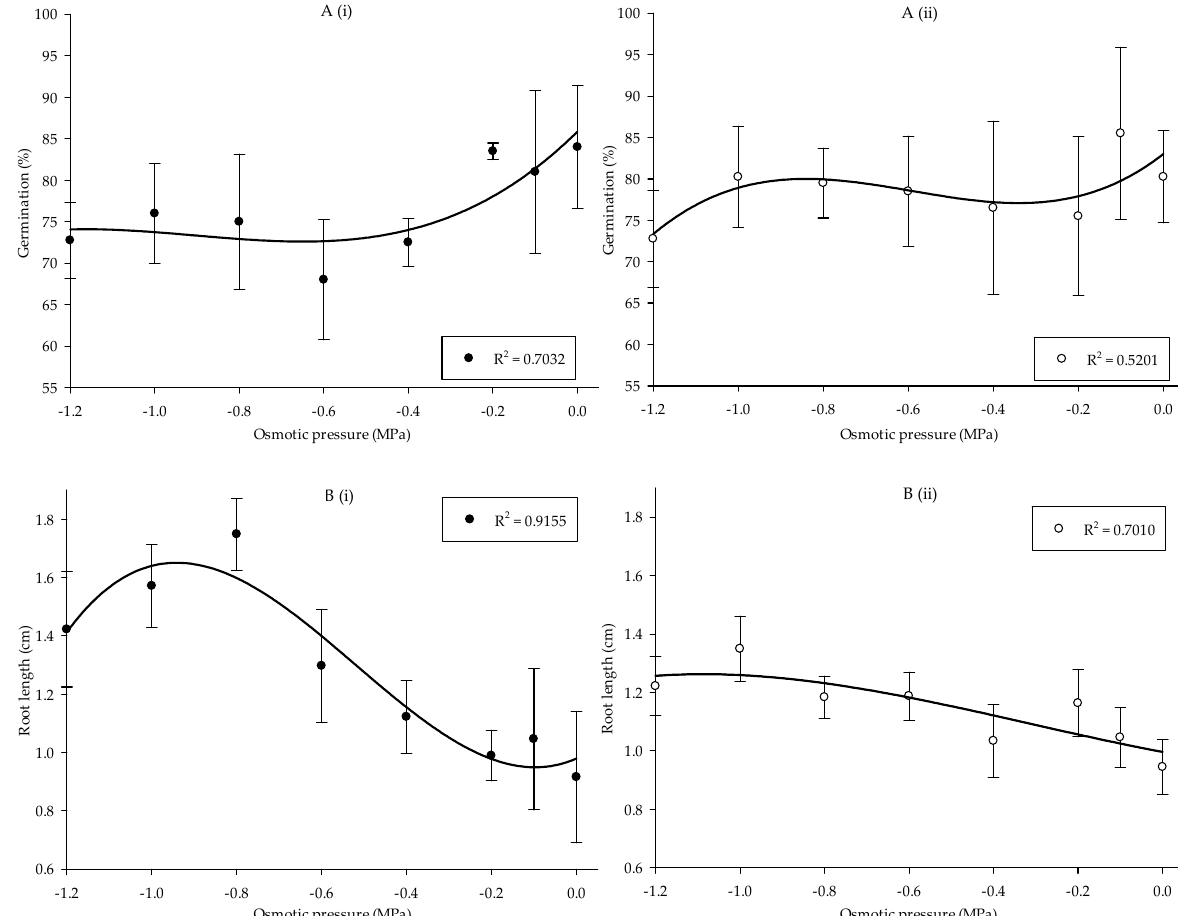
Figure 4. Percentage of seed germination of Pop 1 ( Ai ) and Pop 2 ( Aii ), and root length of Pop 1 ( Bi ) and Pop 2 ( Bii ) of Parthenium weed under different osmotic pressures.